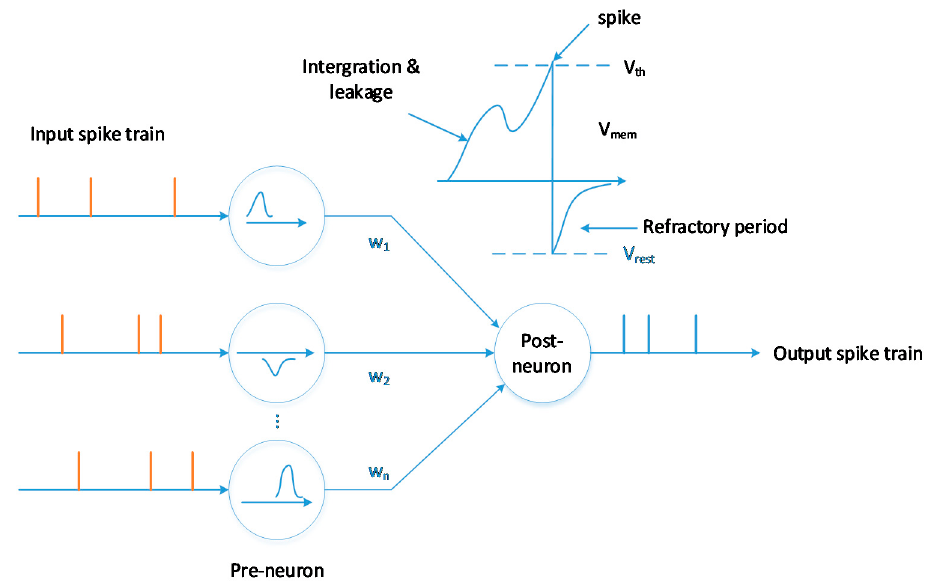
Figure 3. SNN neuron and computation model.